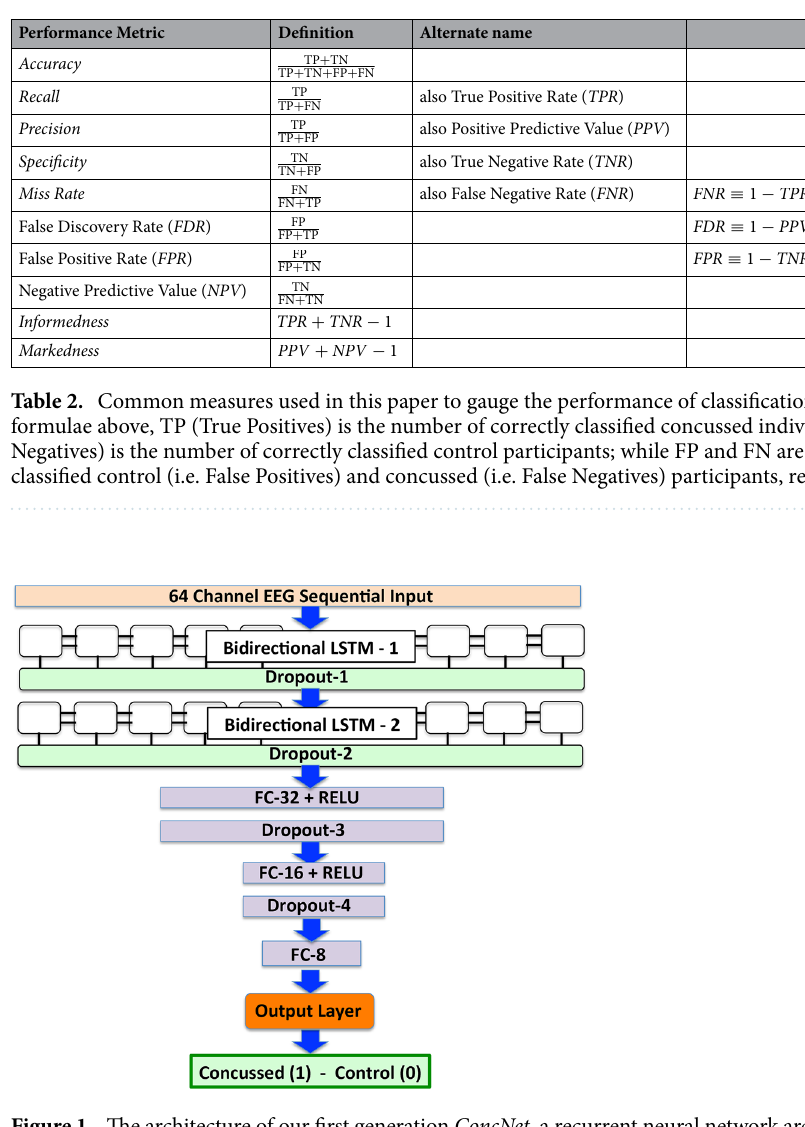
Figure 1. The architecture of our first generation ConcNet , a recurrent neural network architecture comprising two LSTM layers. The 64-channel EEG input is fed through a sequential input layer to the first recurrent layer with 100 bi-directional LSTM units. The output is then passed to a dropout layer for regularization to reduce overfitting, and then to the second LSTM layer, also with 100 bi-directional LSTM units. The output of the 100 LSTM units then passes through another dropout layer, followed by two fully connected and two dropout layers organized as shown. These two fully connected layers have 32 and 16 nodes, and use Rectified Linear Unit activation functions. The results are then fed to a third fully connected layer with 8 nodes. This layer computes the weighted sum of the inputs and passes the output to the final output layer, which uses a logistic function to assign the input raw90-rsEEG data a score ( 0 ≤ P mTBI ≤ 1 ). We classify it as concussed or control on the basis of the score. ( Flow chart created with PowerPoint v14.5.6